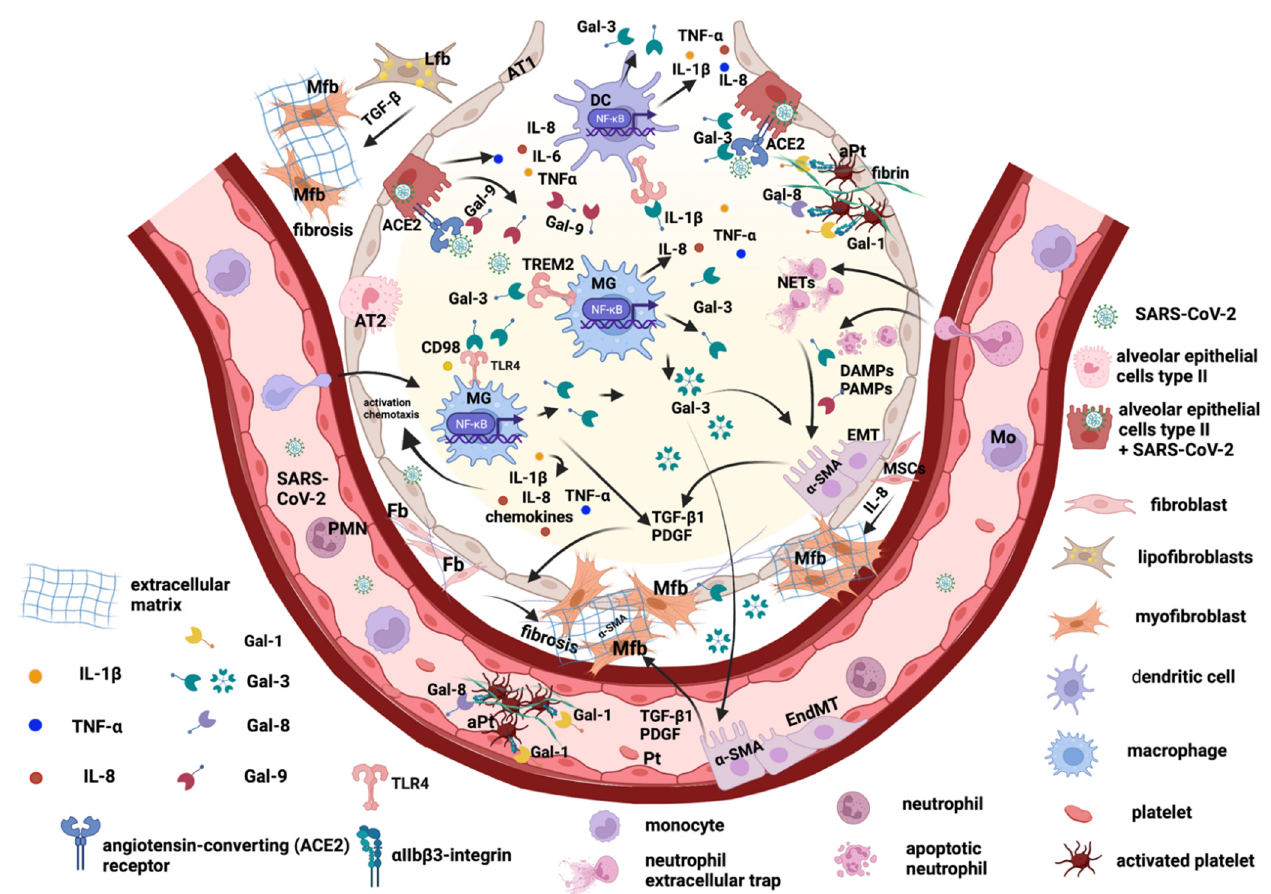
Figure 1. Schematic representation of the galectin-1, -3, -8, and -9 role in the mechanism regulating myofibroblasts activation in pulmonary fibrosis post-COVID-19. macrophages (MG); type I alveolar epithelial cells (AT1); type II alveolar epithelial cells (AT2); dendritic cell (DC); epithelial-mesenchymal transition (EMT); endothelial-mesenchymal transition (EndMT); myofibroblast (Mfb); fibroblast (Fb); lipofibroblasts (Lfb); monocyte (Mo); platelet (Pt); activated platelet (aPt); polymorphonuclear neutrophil (PMN); neutrophil extracellular trap (NETs); angiotensin-converting enzyme 2 receptor (ACE2); mesenchymal stromal cells (MSCs); platelet-derived growth factor (PDGF); transforming growth factor beta1 (TGF- β ). This figure was created with BioRender.com (accessed on 18 July 2022).